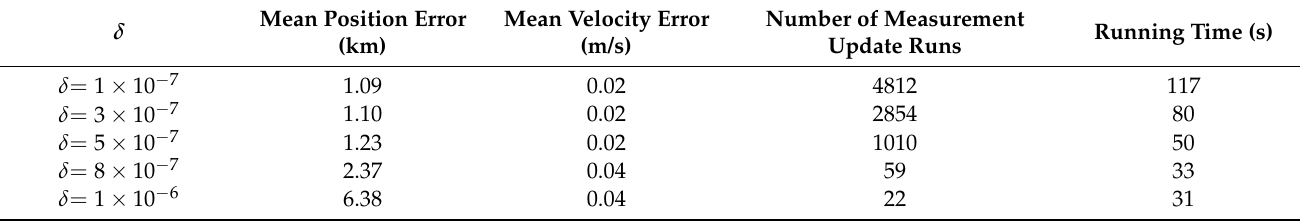
Table 5. Navigation results with different δ